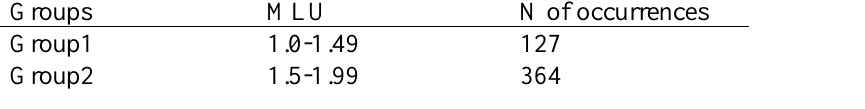
Table 3. Amount of the occurrences of lexicalized/omitted prepositions across MLU groups Groups MLU Group1